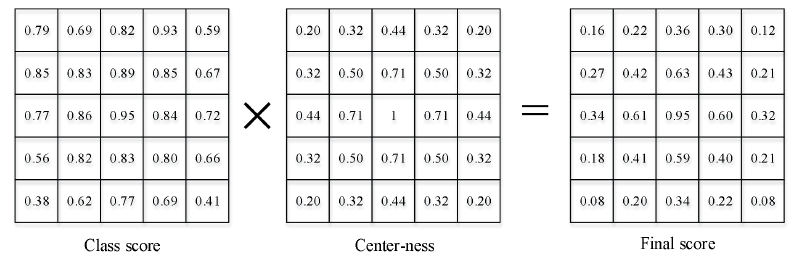
Figure 1. An example of the center-ness suppression process.